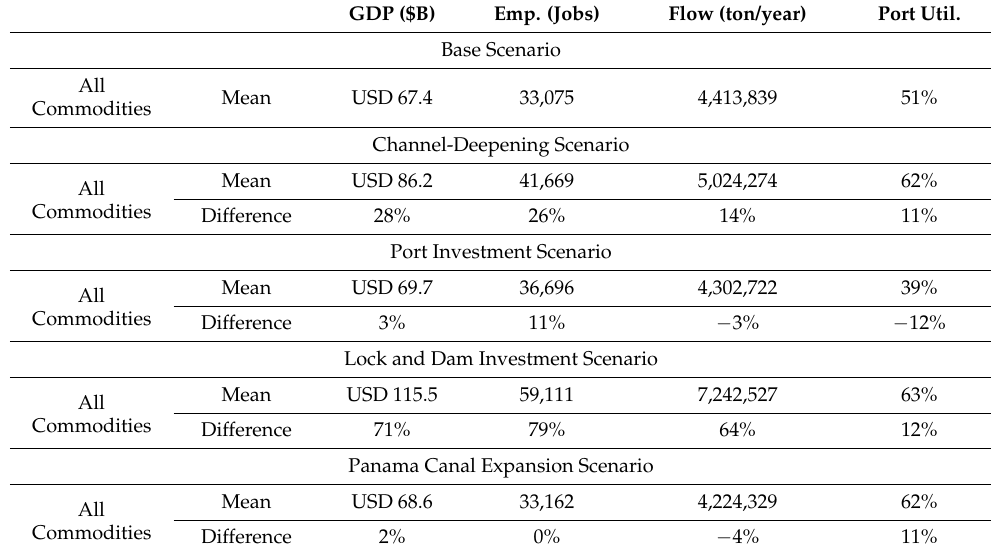
Table 1. Scenario performance measures by commodity.